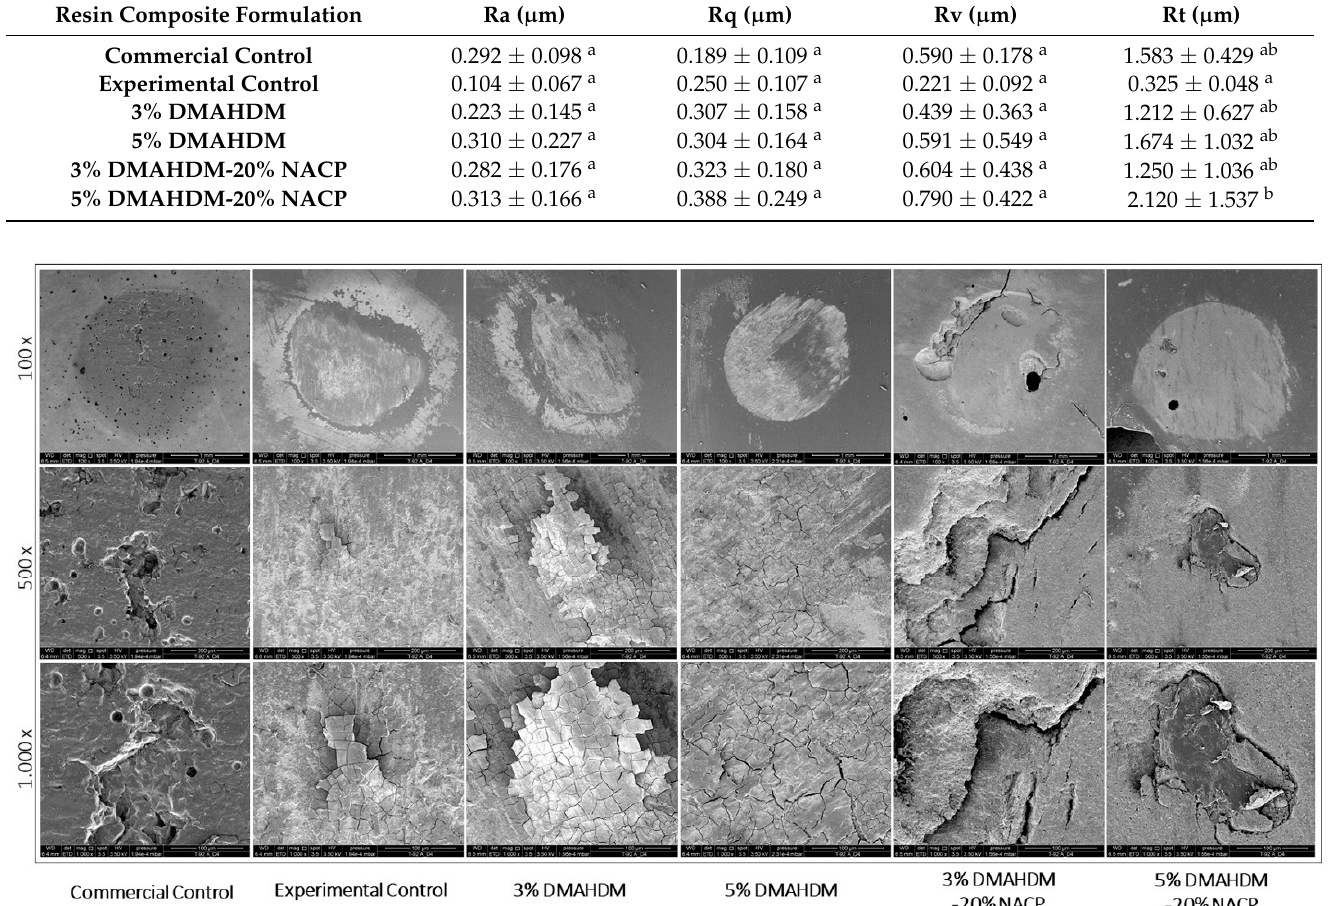
Table 1. The difference in average surface roughness ( Δ Ra), maximum peak height ( Δ Rq), maximum valley depth ( Δ Rv), and the average distance between the highest peak and lowest valley ( Δ Rt) of the resin composite formulations subjected to cyclic fatigue (mean ± SD). Values indicated by different letters are statistically different from each other ( p < 0.05). Resin Composite Formulation